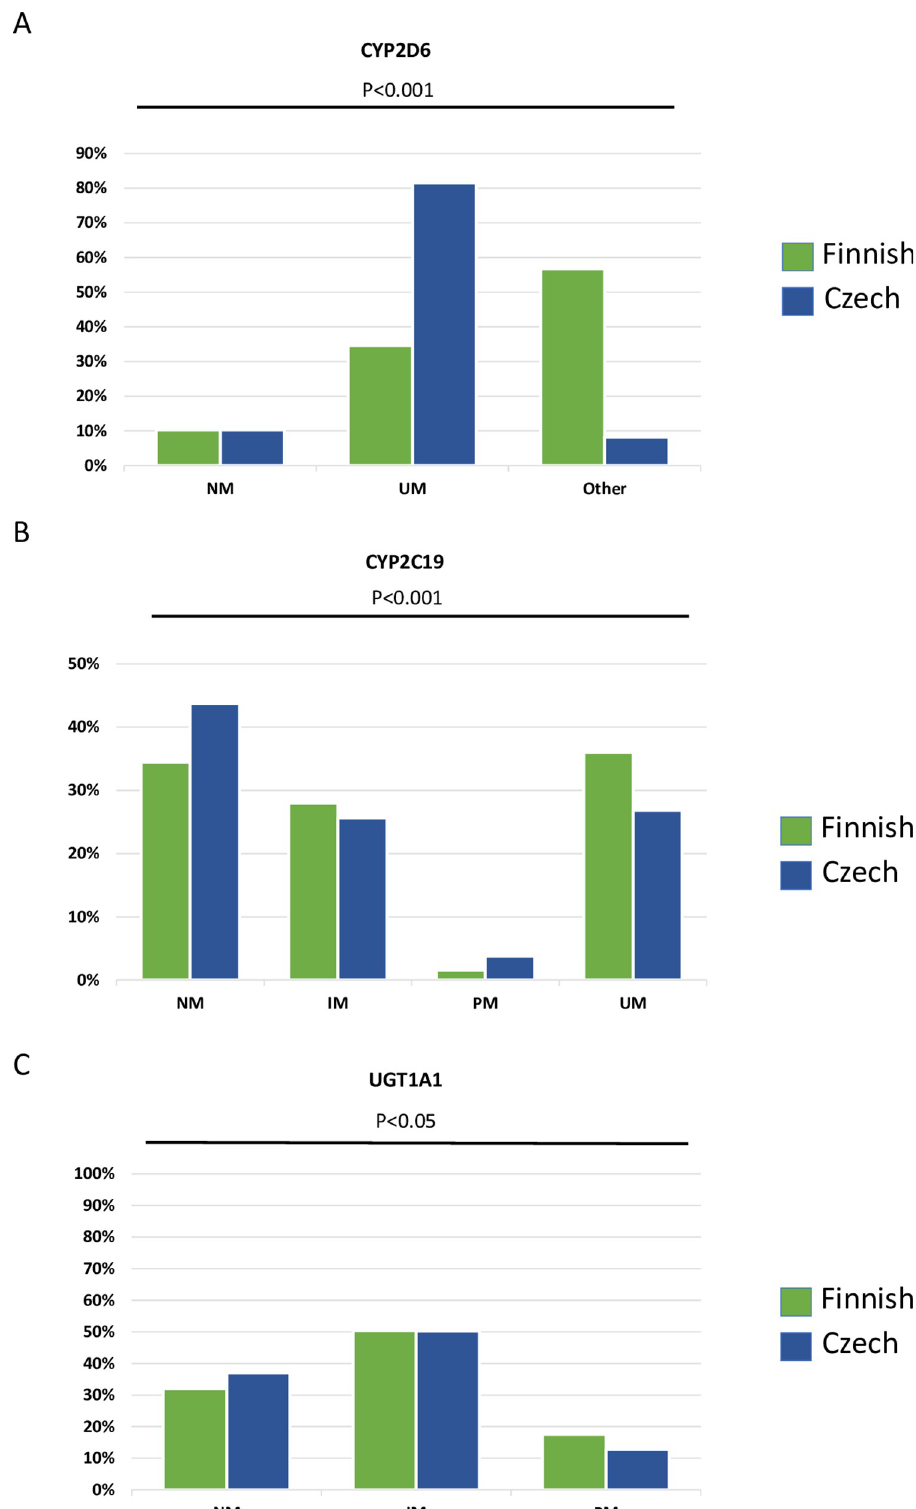
Fig 1. Pharmacogenomics differences between Czech (Kardiovize Brno 2030) and Finnish (SUPER-Finland) reference populations, for the CYP2D6, CYP2C19 and UGT1A1 phenotypes.